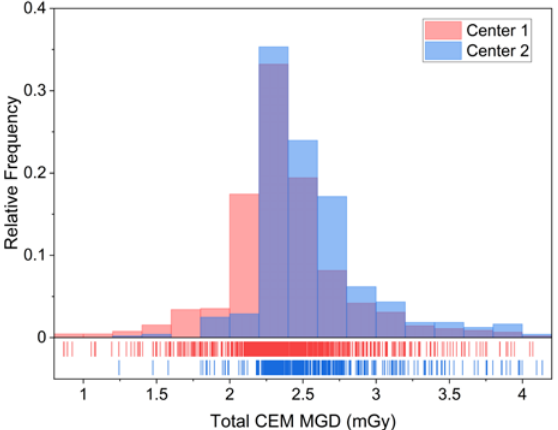
Figure 5. Total CEM MGD histograms for Center 1 (red) and Center 2 (blue). The relative frequency instead of counts was used as the y-axis in order to cope with the difference in size between the two datasets. The degree of overlap between the two distributions is shown in the darker central part of the plot. The rug at the bottom is composed by the projections of data points on the CEM MGD continuous axis by means of thin lines, better showing the slight dose increase by the CEM system at Center